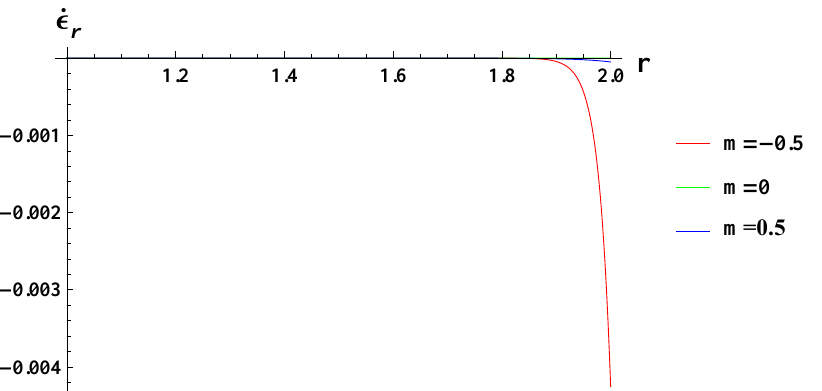
Figure 27. Radial strain rate along the radius r (in cm) of the cylinder, under the effect of rotation ( ω 2 = 50 rad/s), external pressure p o = 50 MPa and quadratic volume reinforcement.